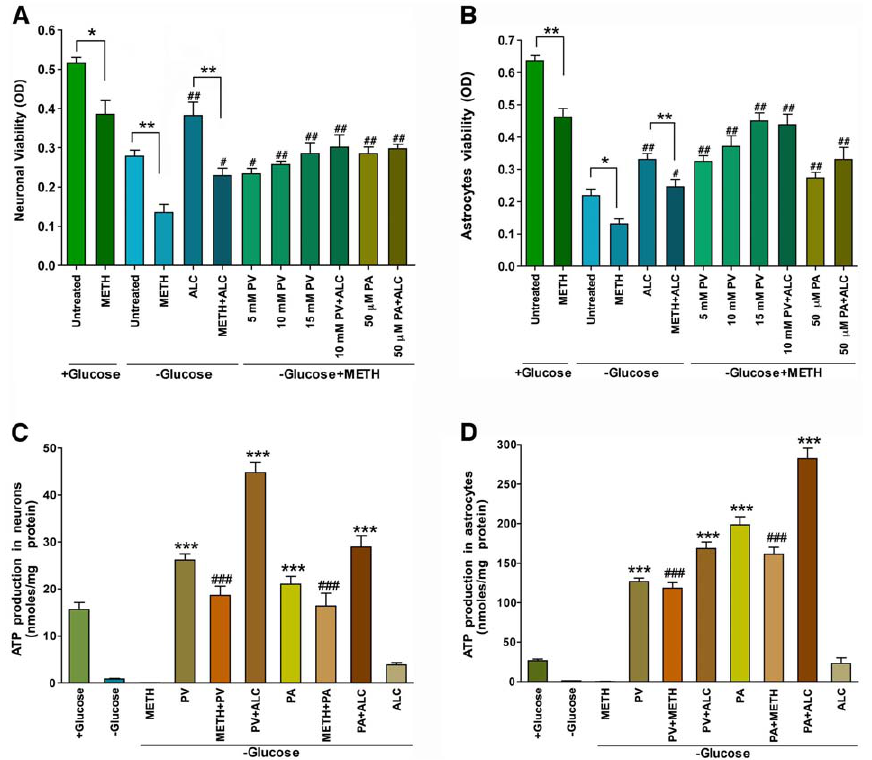
Figure 9. Utilization of pyruvate/palmitate by neurons and astrocytes during glucose deprivation and METH insult: Primary human neurons and astrocytes cultured in 96 well plates (20000 cells/well) in normal ( + glucose) or glucose-free (- glucose) media were exposed to 100 m M METH for 48 hr, and were analyzed for cell viability and ATP production. Viability of cells in glucose-deprived culture supplemented with pyruvate (PV)/palmitate (PA) in the presence or absence of ALC (100 m M) in ( A ) neurons and ( B ) astrocyte. Production of ATP in glucose-deprived culture with PV/PA in the presence or absence of ALC, ( C ) in neurons and ( D ) in astrocytes. Untreated ( + ) glucose is a positive control and untreated (-) glucose is a negative control. Results are expressed as mean values ( 6 SEM; n=3 in A and B ; n=5 in C and D ). Statistically significant *p , 0.05 and **p , 0.01 compared with respective conditions (adjacent bars) in A and B ; ***p , 0.001 with compared with (-) glucose in C and D ; # p , 0.05 and ## p , 0.01 compared with (-) glucose + METH in A and B, and ### p , 0.001 with compared with (-) glucose + METH condition in C and D